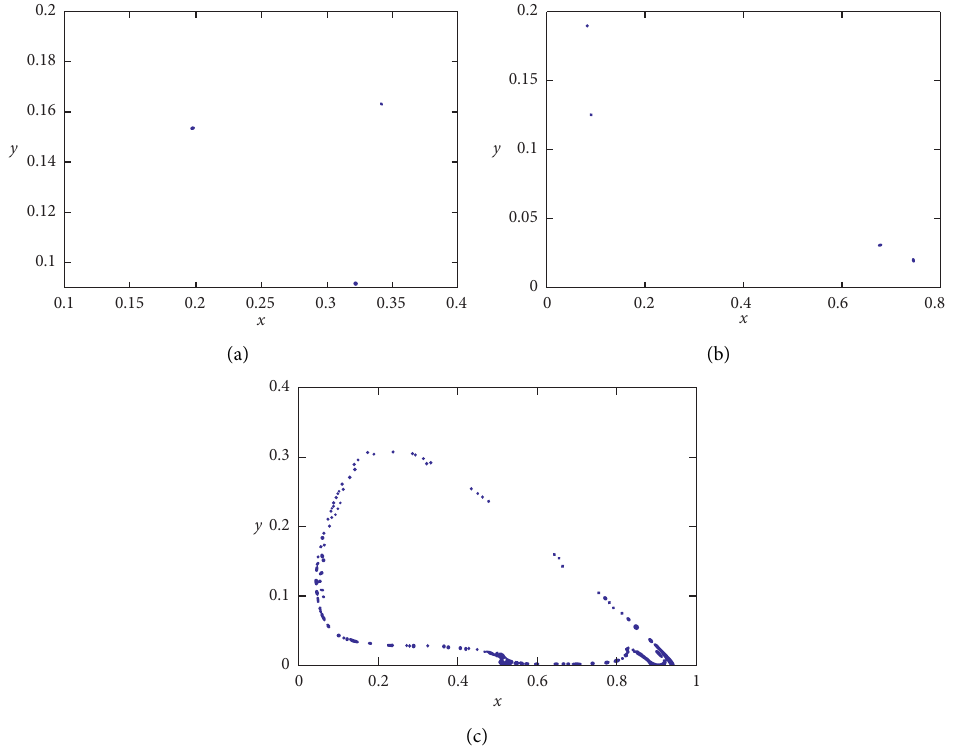
Figure 14: Effect of α on Poincar´e section of nonlinear chemical reaction with g � 0.002 and other parameters of Figure 13: (a) α � 0.03: attractor of period 3 T ; (b) α � 0.028: attractor of period 4 T ; (c) α � 0.02: chaotic